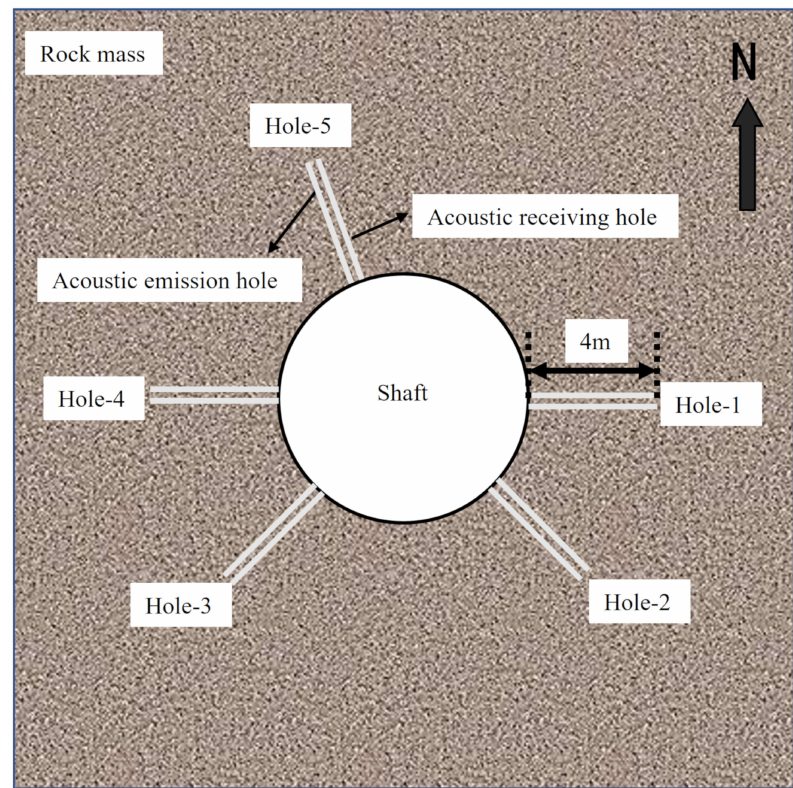
Figure 13. Arrangement of test holes in the plastic region of the